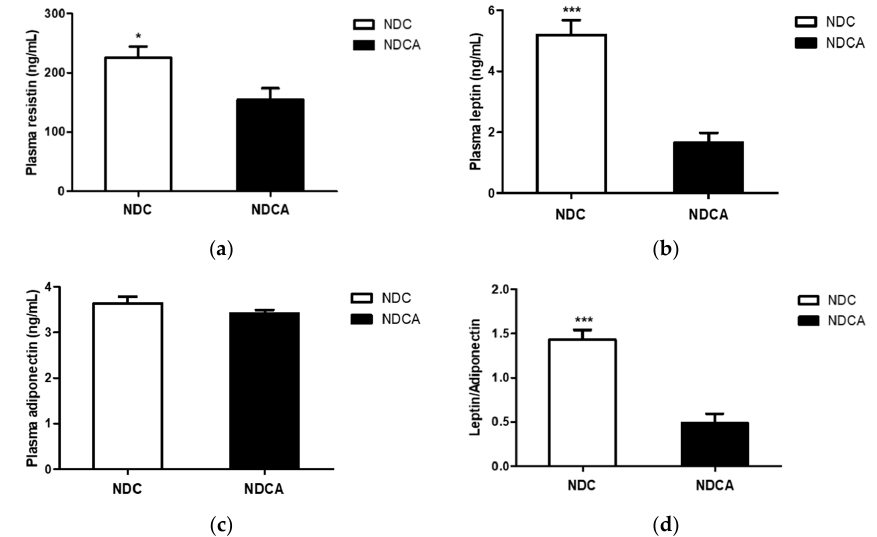
Figure 8. Effect of supplementation of non-dairy creamer-enriched high-fat diet with D-allulose on changes in plasma adipokines in C57BL/6J mice fed the diet for 8 weeks; ( a ) plasma resistin; ( b ) plasma leptin; ( c ) plasma adiponectin; ( d ) plasma leptin-to-adiponectin ratio. Data are mean ± SE. Significant di ff erences between the 5% D-allulose group and without D-allulose group are indicated; * p < 0.05, *** p < 0.001. NDCA, high-fat diet with non-dairy creamer + 5% D-allulose; NDC, high-fat diet with non-dairy